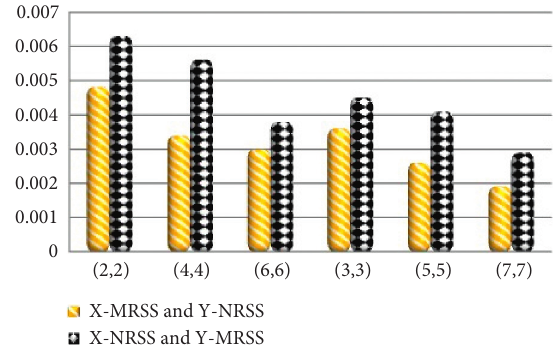
Figure 8: MSE of SSR estimate based on NRSS and MRSS at R �